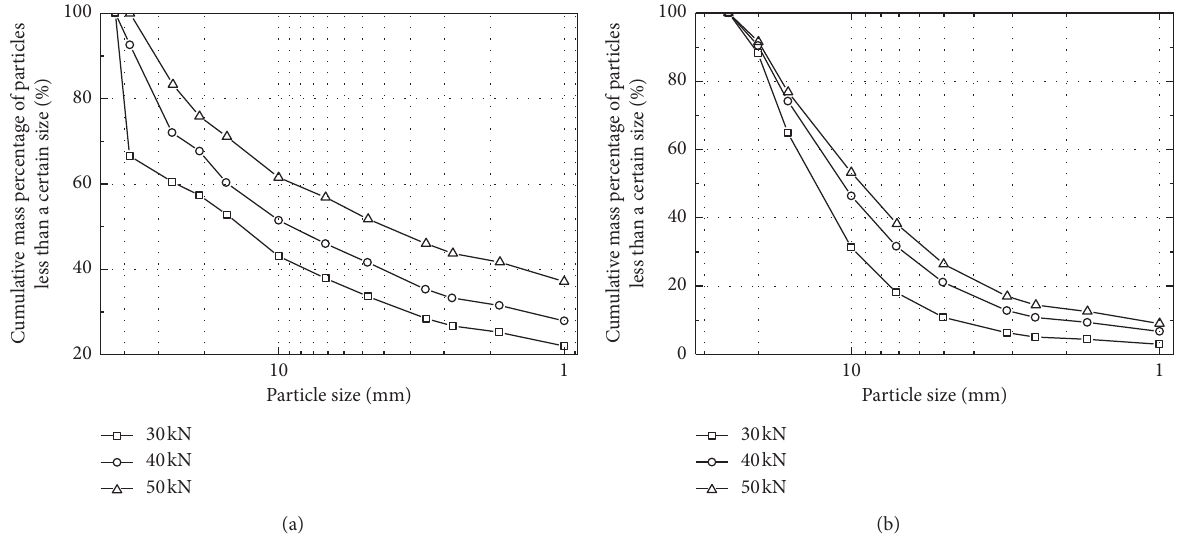
Figure 10: The fragment sieving curves of particles under the loading of 30, 40, and 50 kN: (a) 3 and 4 cm mixed cement mortar particles; (b) cement